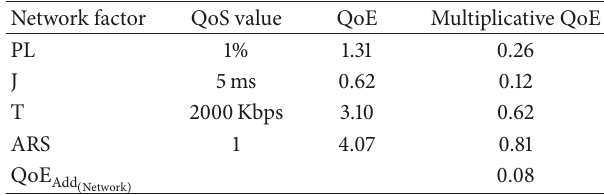
Table 13: Criteria comparison matrix for network factors.